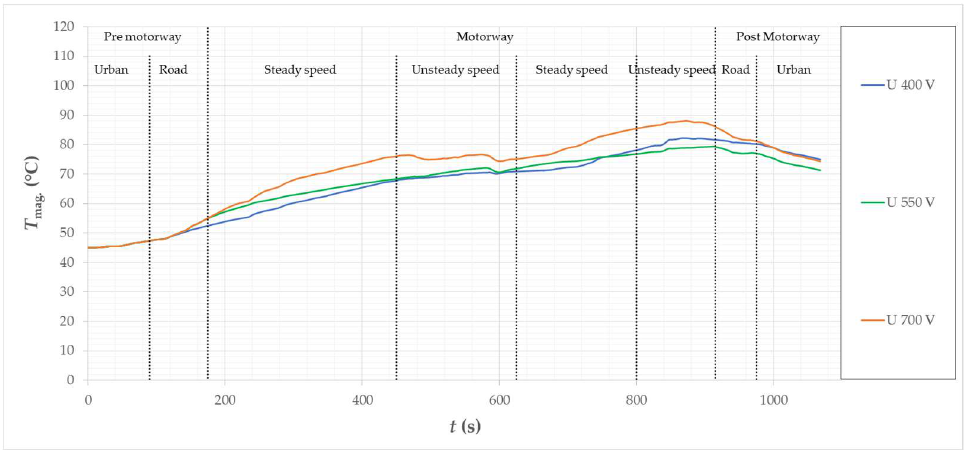
Figure 38. Calculated temperature waveforms in permanent magnets of the motor for the considered vehicle in the Motorway150 driving cycle.